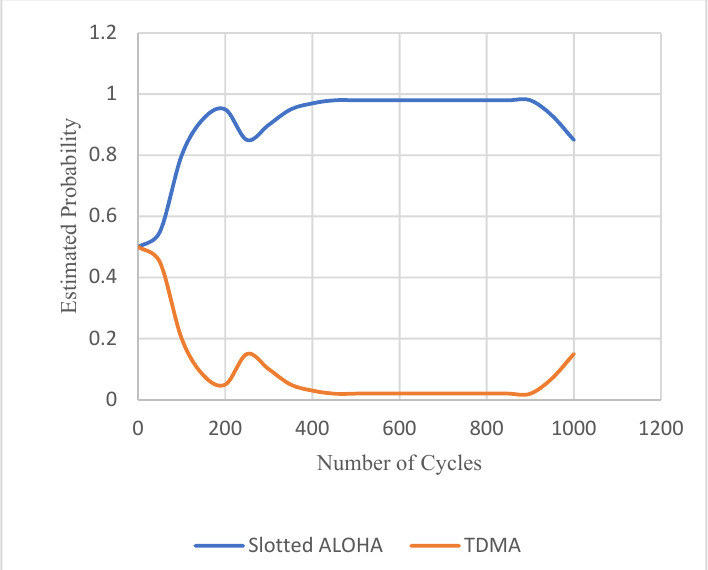
Figure 11. Convergence of automaton estimation of MAC protocol selection probabilities.